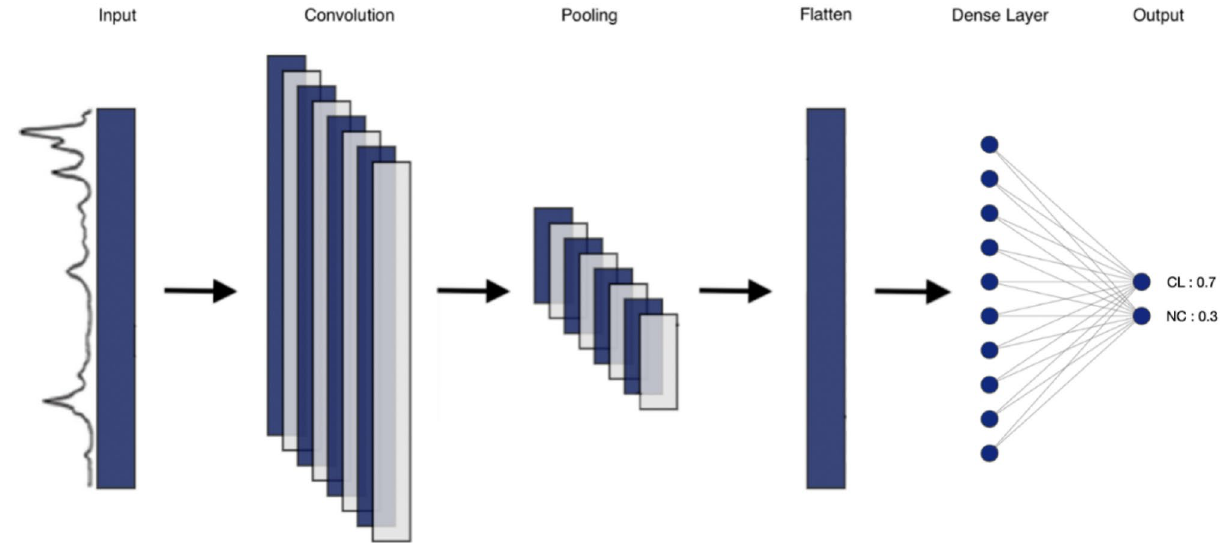
Figure 3. Schematization of the CNN model used for this experiment. The 6 layers are represented (input layer, convolutional layer, max pooling layer, Flatten layer, fully connected layer, and softmax layer). There are two output classes: Clones (CL) and Nonclones (NC). The sum of the predictions for each output classes is always equal to